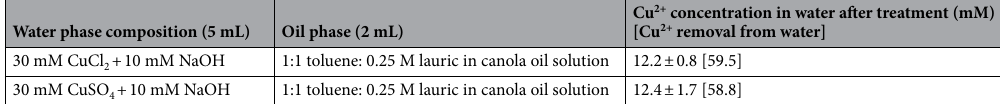
Table 9. ICP analyses of the water phase of samples prepared starting with 30 mM CuSO 4 or CuCl 2 , using toluene and lauric acid solutions in canola oil. Measurements were done immediately after filtering the samples through the injectable